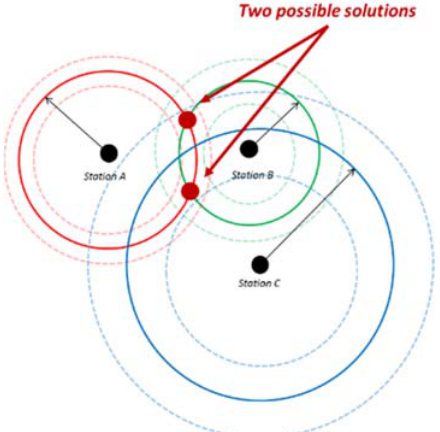
Figure 2. Illustration of ambiguity in lateration for the case of unfavorable network geometry and large ranging